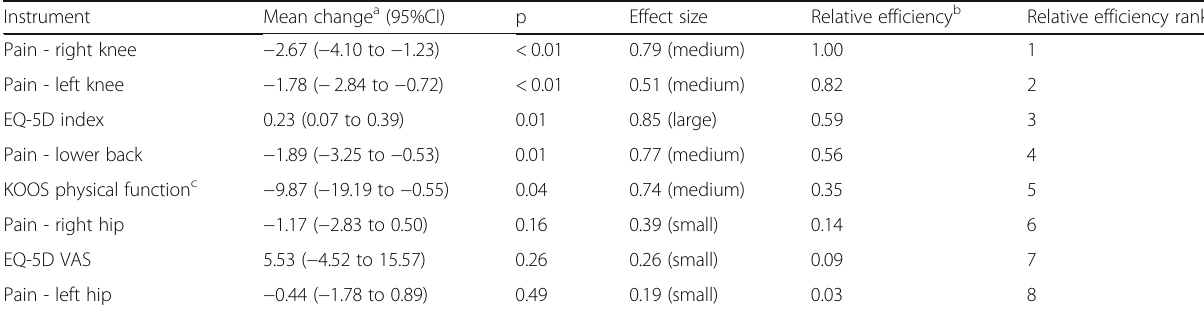
Table 3 Effect sizes from baseline to 6 weeks ( n = 22) and relative efficiency